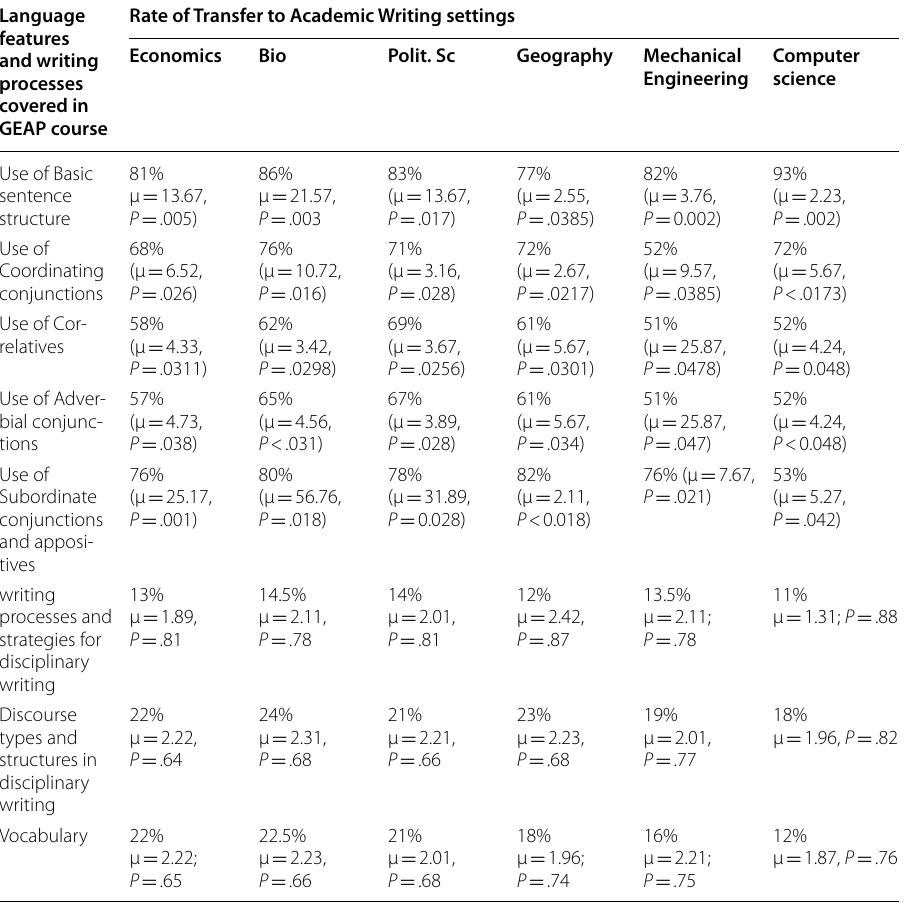
Table 3 Transfer of language features and writing processes across academic writing settings Language